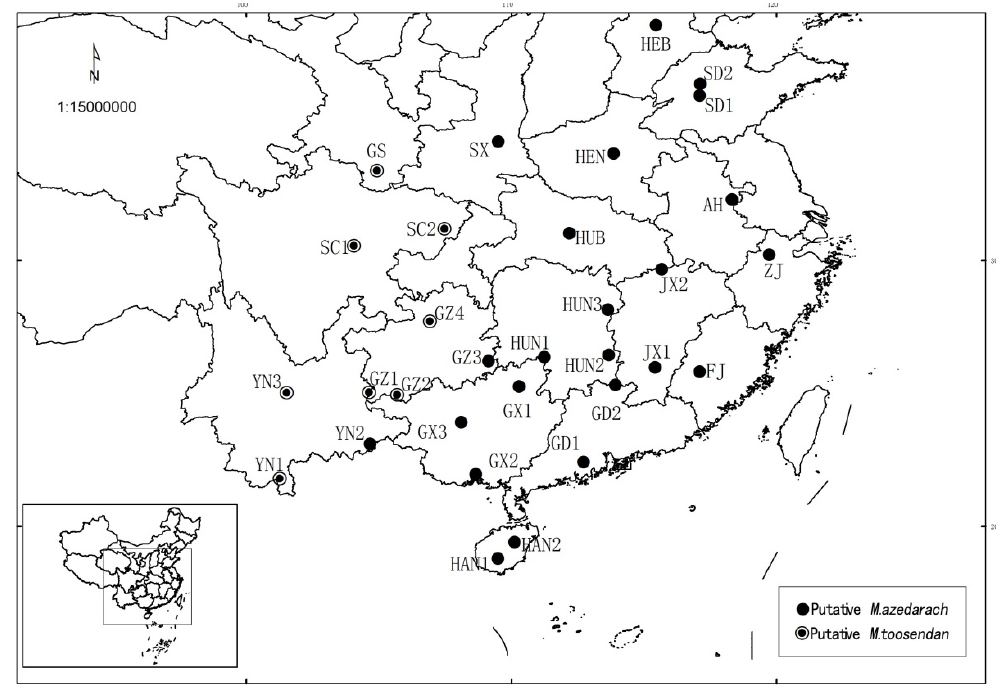
Figure 1. Geographical locations of the sampled populations covering the taxa of both M. azedarach and M. toosendan . Codes for the populations are given in Table 1.